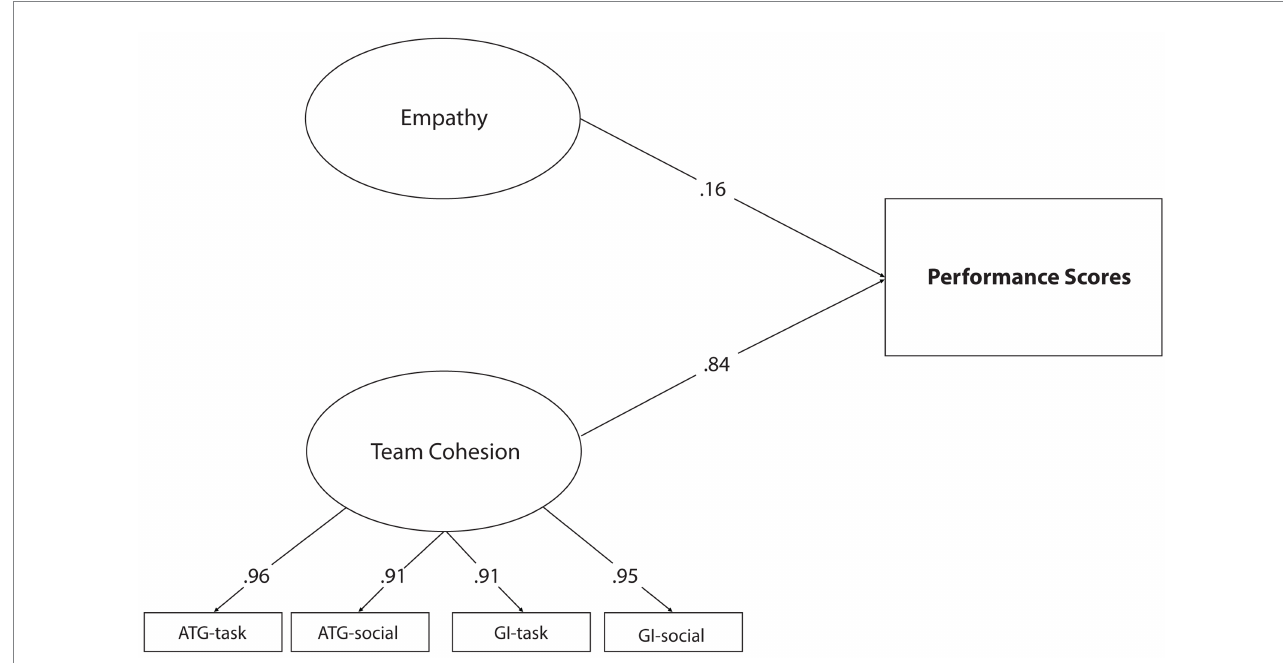
FIGURE 1 Standardized SEM results for Model